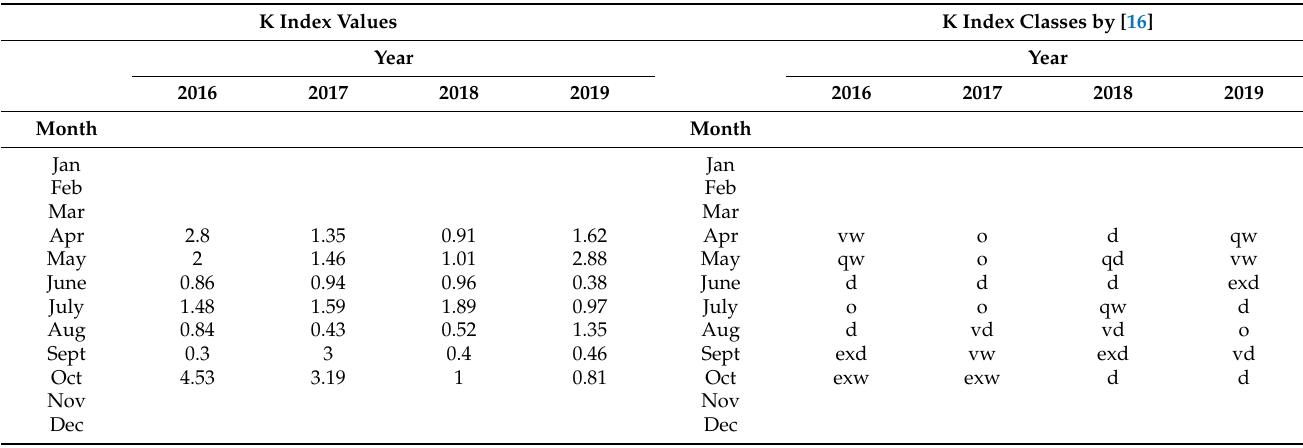
Table 2. Values and classes of the Selyaninov hydrothermal index (K) for the vegetative seasons during the study years. See above for explanations of the